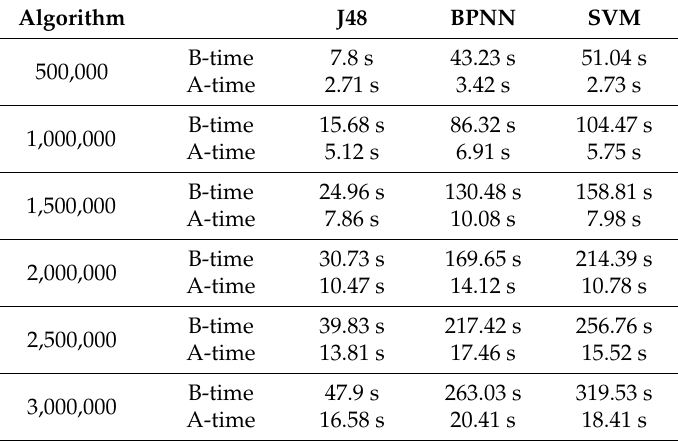
Table 3. The comparison of classification time.